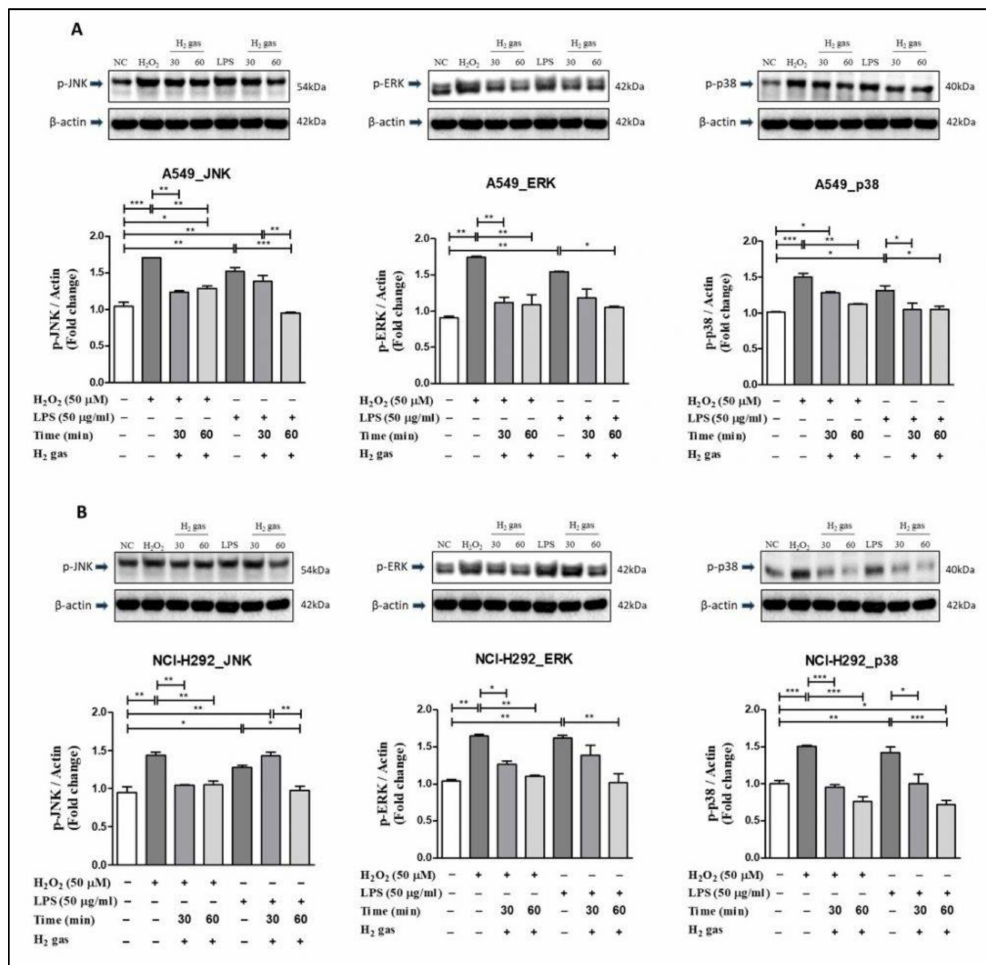
Figure 6. Effect of 2% H 2 gas on MAPK pathway proteins in cells treated with H 2 O 2 and LPS. MAPK proteins p-JNK, p-ERK, and p-p38 were analyzed following H 2 treatment of ( A ) A549 cells; and ( B ) NCI-H292 cells and compared with untreated controls. Image J was used to analyze the data. Data are presented as mean ± SEM. * p < 0.05, ** p < 0.01 and *** p < 0.001 represent the level of significance based on